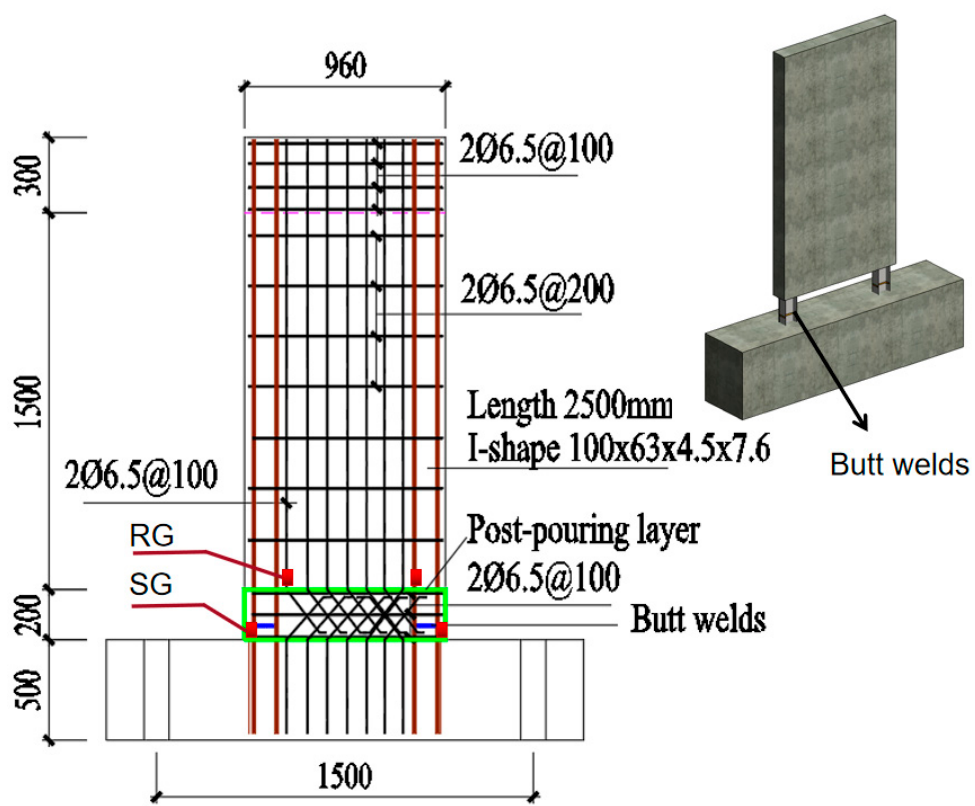
Figure 3. Layout of the wall specimen with the connection at the bottom of the wall (named XZW1 and 2). Unit: mm. RG represents “strain gauge attached on the reinforcing bar”, and SG “strain gauge attached on the I-steel section” ( Φ is the diameter of bars , @ is the center-to-center distance of bars.)